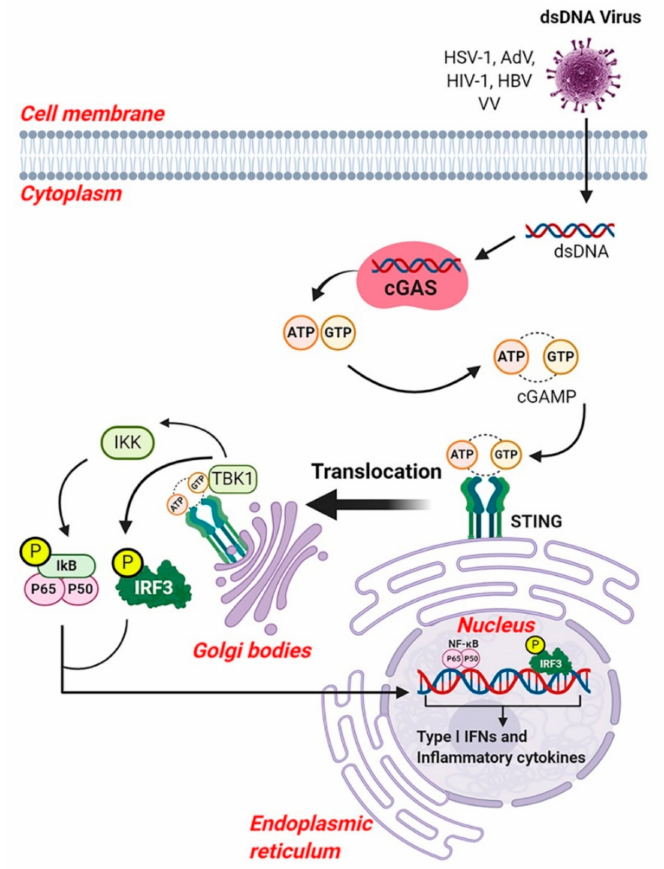
Figure 6. The cGAS-STING signaling pathway. Cyclic GMP-AMP synthase (cGAS) are cytosolic DNA sensors, capable of sensing dsDNA. After recognition of dsDNA, cGAS catalyzes the formation of cyclic GMP-AMP (cGAMP), which in turn binds to stimulator of IFN genes (STING), located on the endoplasmic reticulum membrane. The binding of cGAMP to STING promotes the translocation of STING to Golgi bodies. During translocation, STING triggers the activation of TBK1 and IKK complexes. This complex then causes the phosphorylation of IRF3 and NF- κ B. The active IRF3 and NF- κ B (p65/p50) translocate into the nucleus and activate the transcription of type I IFNs and other inflammatory cytokines. ‘P’ indicates phosphorylation. AdV: Adenovirus; HBV: Hepatitis B virus; HIV-1: Human immunodeficiency virus 1; HSV-1: Herpes simplex virus 1; VV: Vaccinia